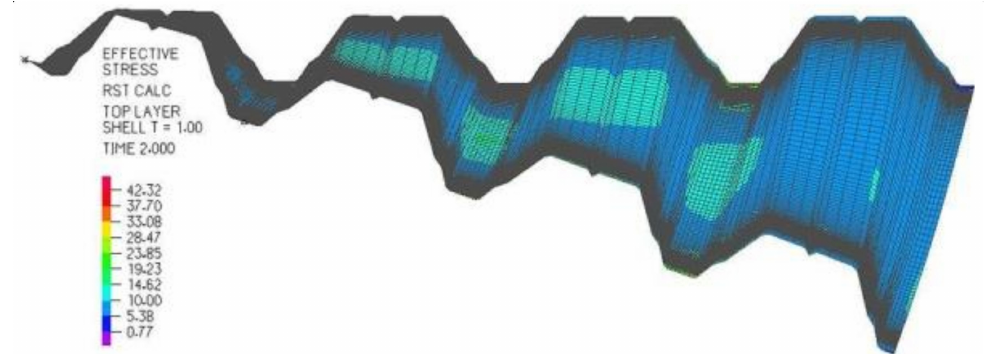
Figure 3. The accurate computational mechanical model of an elastically transformed sheet and the graphical expression of the “effective” stresses in MPa on its top